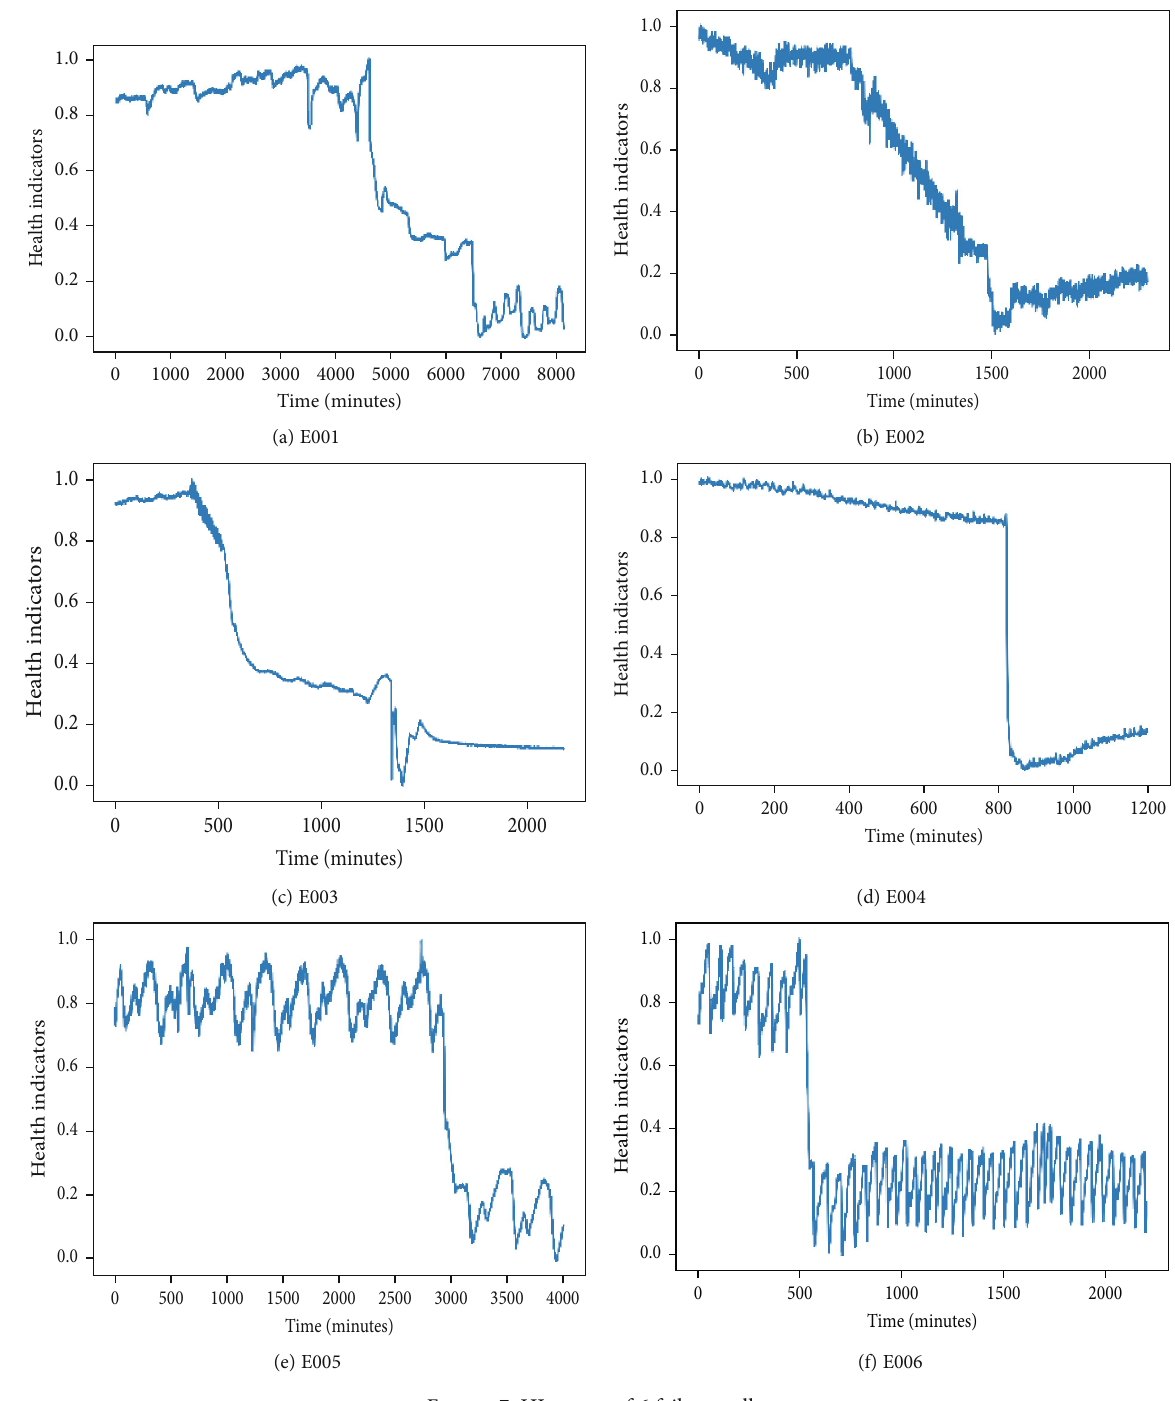
Figure 7: HI curves of 6 failure